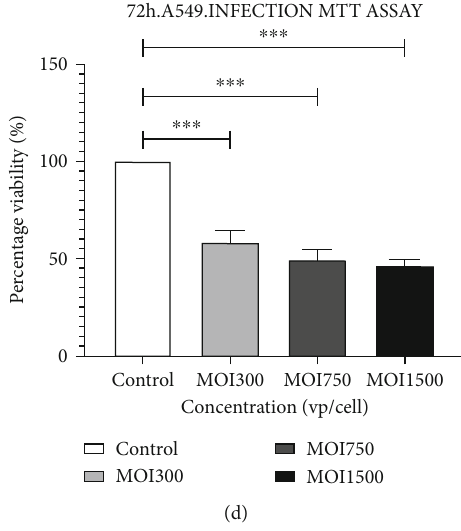
Figure 1: The e ff ect of HAdV3 on A549 viability. (a) Intracellular esterase activity of viable A549 cells. Cells were labeled with non fl uorescent calcein-AM dye which is converted to green fl uorescent molecules as a result of ester hydrolysis. The images were acquired at the indicated time after incubation. (b) Postinfection quanti fi cation of viable A549 cells after incubation with 3-(4,5- dimethylthiazol-2-yl)-25-diphenyltetra bromide after 24h (c) 48h, and (d) 72 h. The cells were incubated with dye solution at 37 ° C for 3-4 h; absorbance was read at 570nm. Data shows the mean ± SEM from four independent experiments performed using one-way analysis of variance (ANOVA) with Tukey post hoc analysis. Statistical signi fi cance is indicated by the mean ± SD as follows: ∗ p < 0 : 05 , ∗∗ p < 0 : 01 , ∗∗∗ p < 0 : 001 , and ∗∗∗∗ p < 0 : 0001